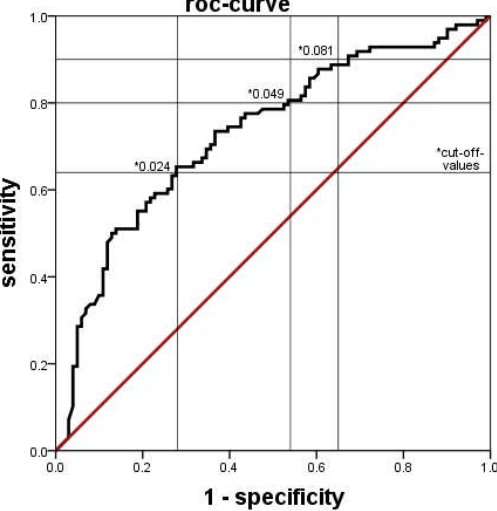
Figure 4. ROC-curve of the diagnostic accuracy of detecting a probable infection by the xn-ratio as determined by the Sysmex XN-9000 ® . The area under the curve was 0.727. * Several different cut-off values with their respective sensitivity and specificity are indicated.